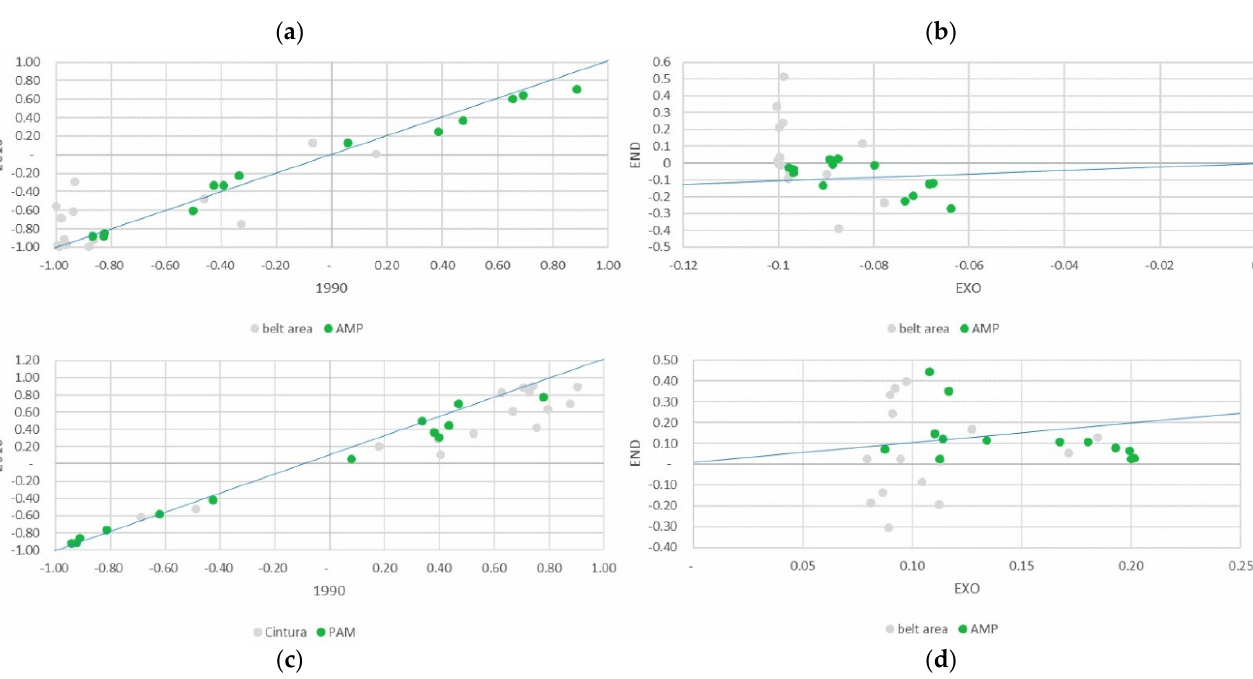
Figure 19. ( a – d ) PSI and DPSI for Cereals and Olive trees. Source: Drawn up by the authors using data from the ISTAT.